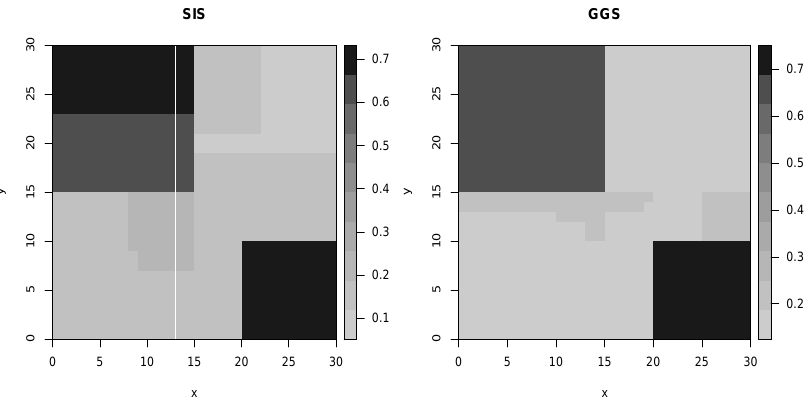
Figure 7. Surface profiles as determined by the GGS and the SIS algorithms (Example 2).